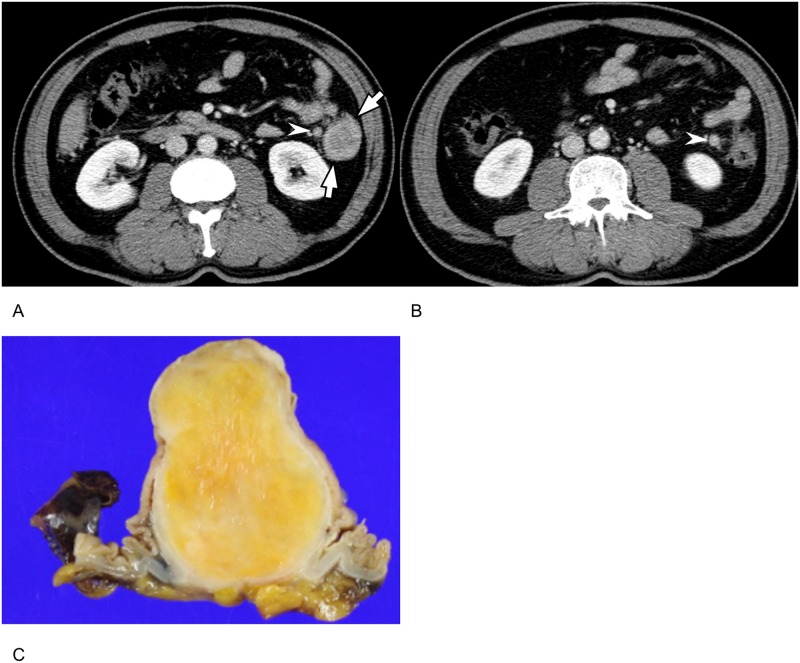
A 58-year-old man with colonic schwannoma.(A), (B). On portal phase axial CT images, a 3.9 cm round mass (arrow, A) is noted at the descending colon. The mass shows homogeneously higher attenuation than back muscle with smooth margin. Note the two enlarged enhancing lymph nodes (arrowheads) at pericolic area. (C). A photograph of the cut surface of gross specimen obtained after left hemicolectomy shows a well-defined endophytic subepithelial mass in the colon. Tumor cells are diffuse and strongly S-100 protein positive on immunohistochemistry and confirmed as colonic schwannoma involving the submucosa and proper muscle (not shown).